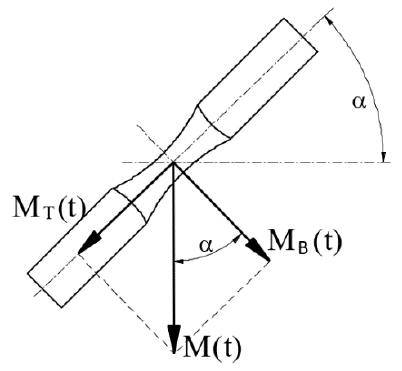
Figure 3. Configuration of specimen loading where: M T —torsion, M B —bending, M—total moment.